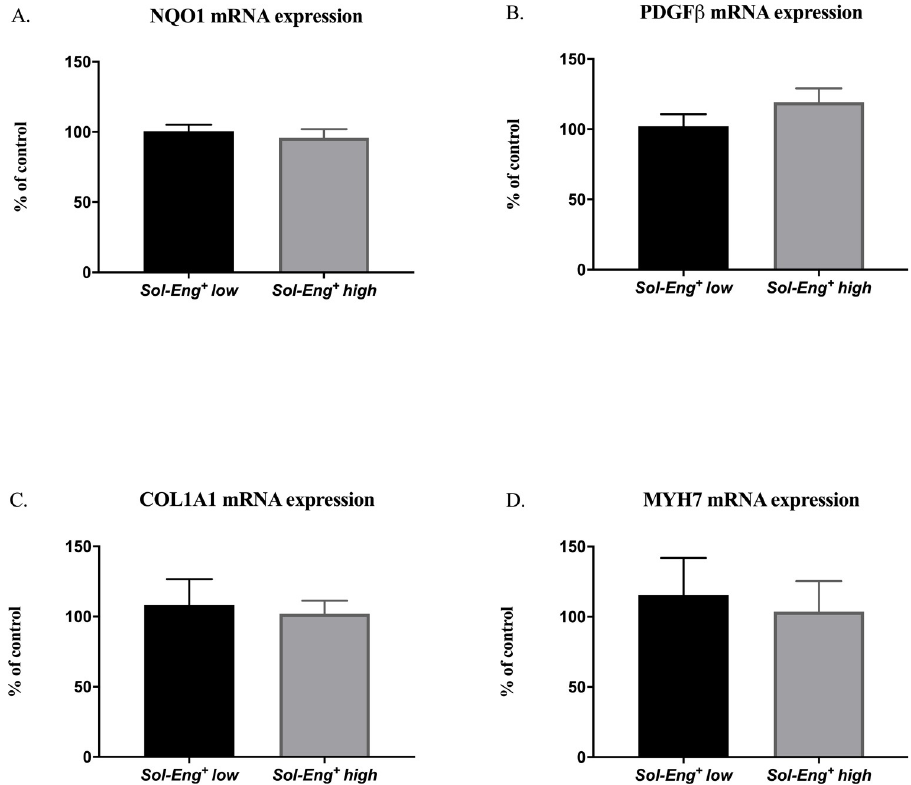
Fig 4. Sol-Eng + high mice do not exhibit signs of activated oxidative stress or heart remodeling status. mRNA expression of NQO1 (A), PDGF β (B), COL1A1 (C) and MYH7 (D). Data are shown as mean ± S.E.M., Mann-Whitney test. n = 7 mice per